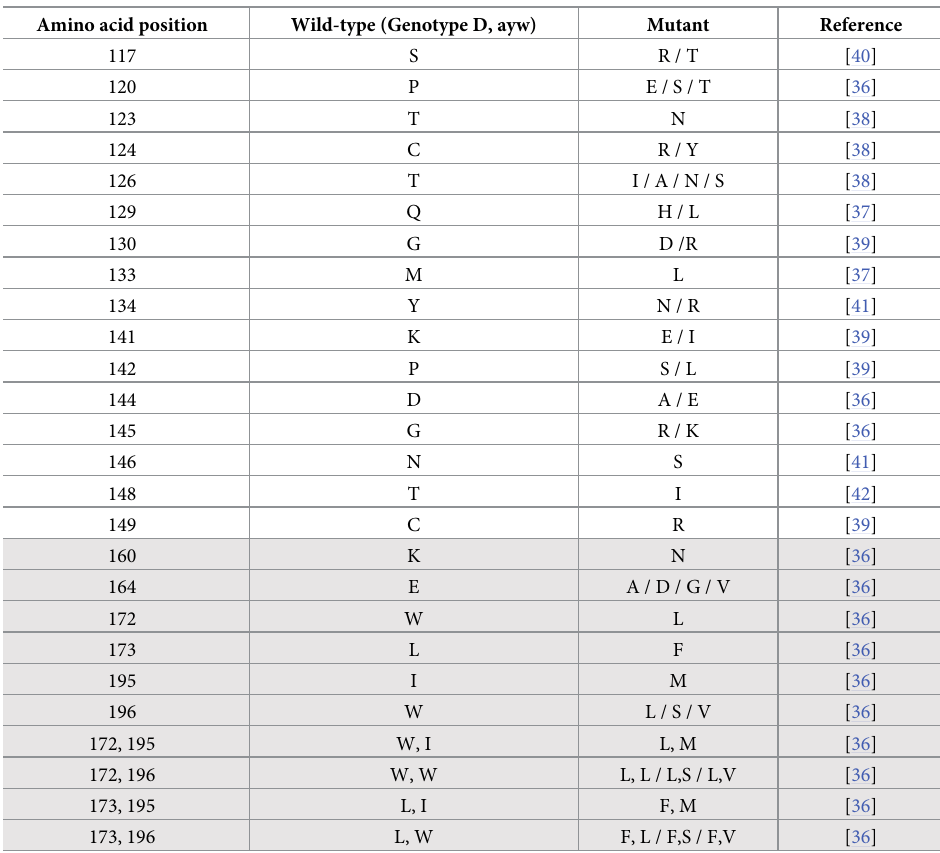
Table 2. S gene mutations investigated in this study. Amino acid position Wild-type (Genotype D,